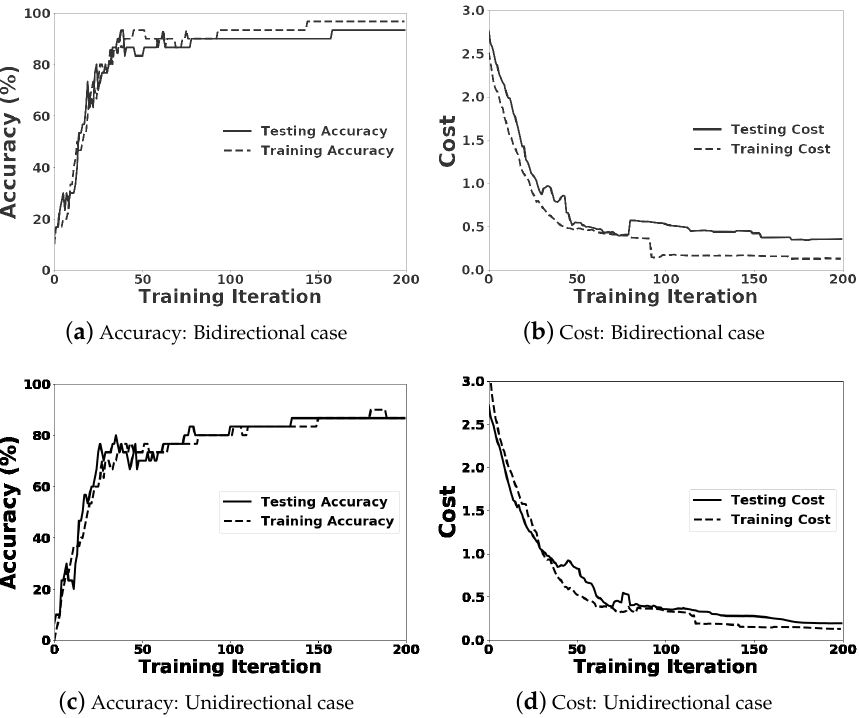
Figure 7. Learning curves on accuracy and cost for the bidirectional and unidirectional LSTM RNN